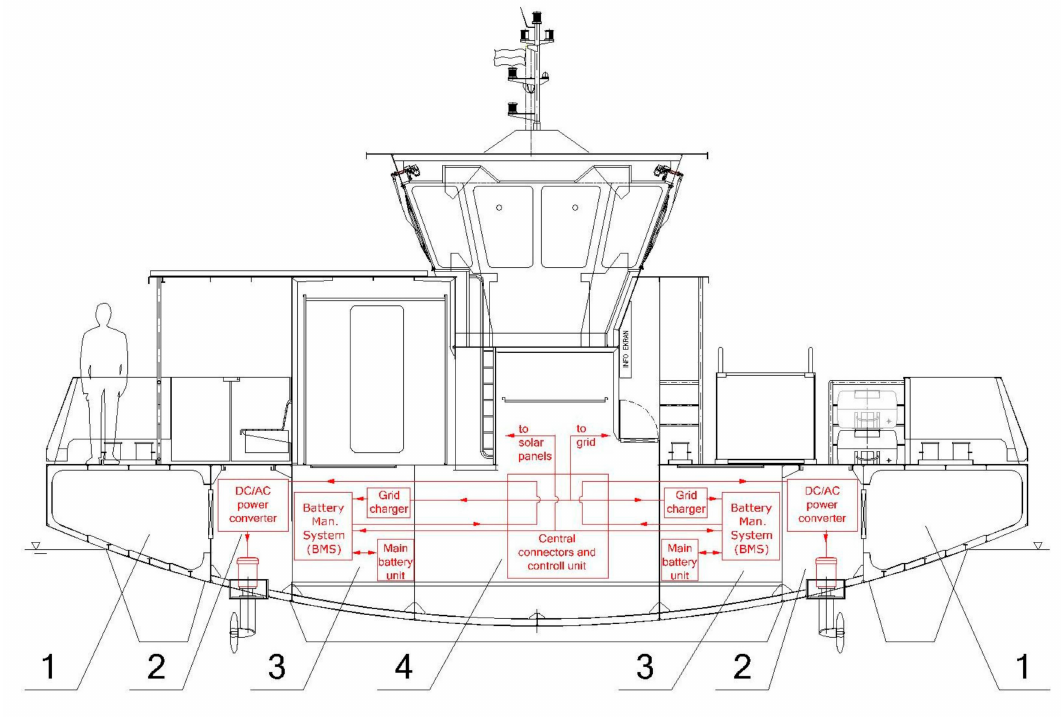
Figure 1. Propulsion and power supply system schematic of the Motława II Ferry; 1—collision bulkhead; 2—propulsion compartment, 3—battery compartment, 4—crew room with main